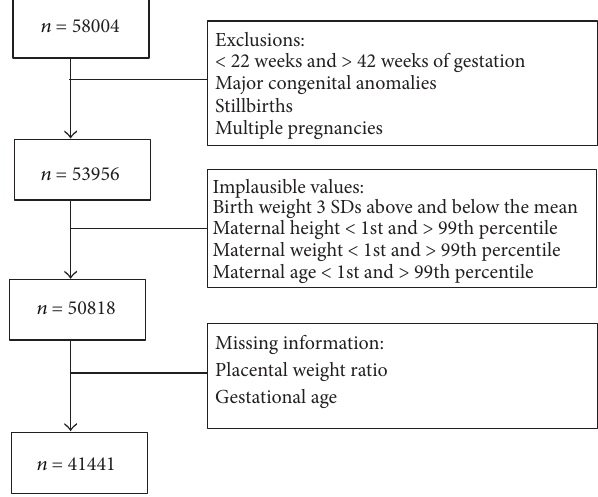
Figure 1: Flow chart illustrating the process by which the study population was